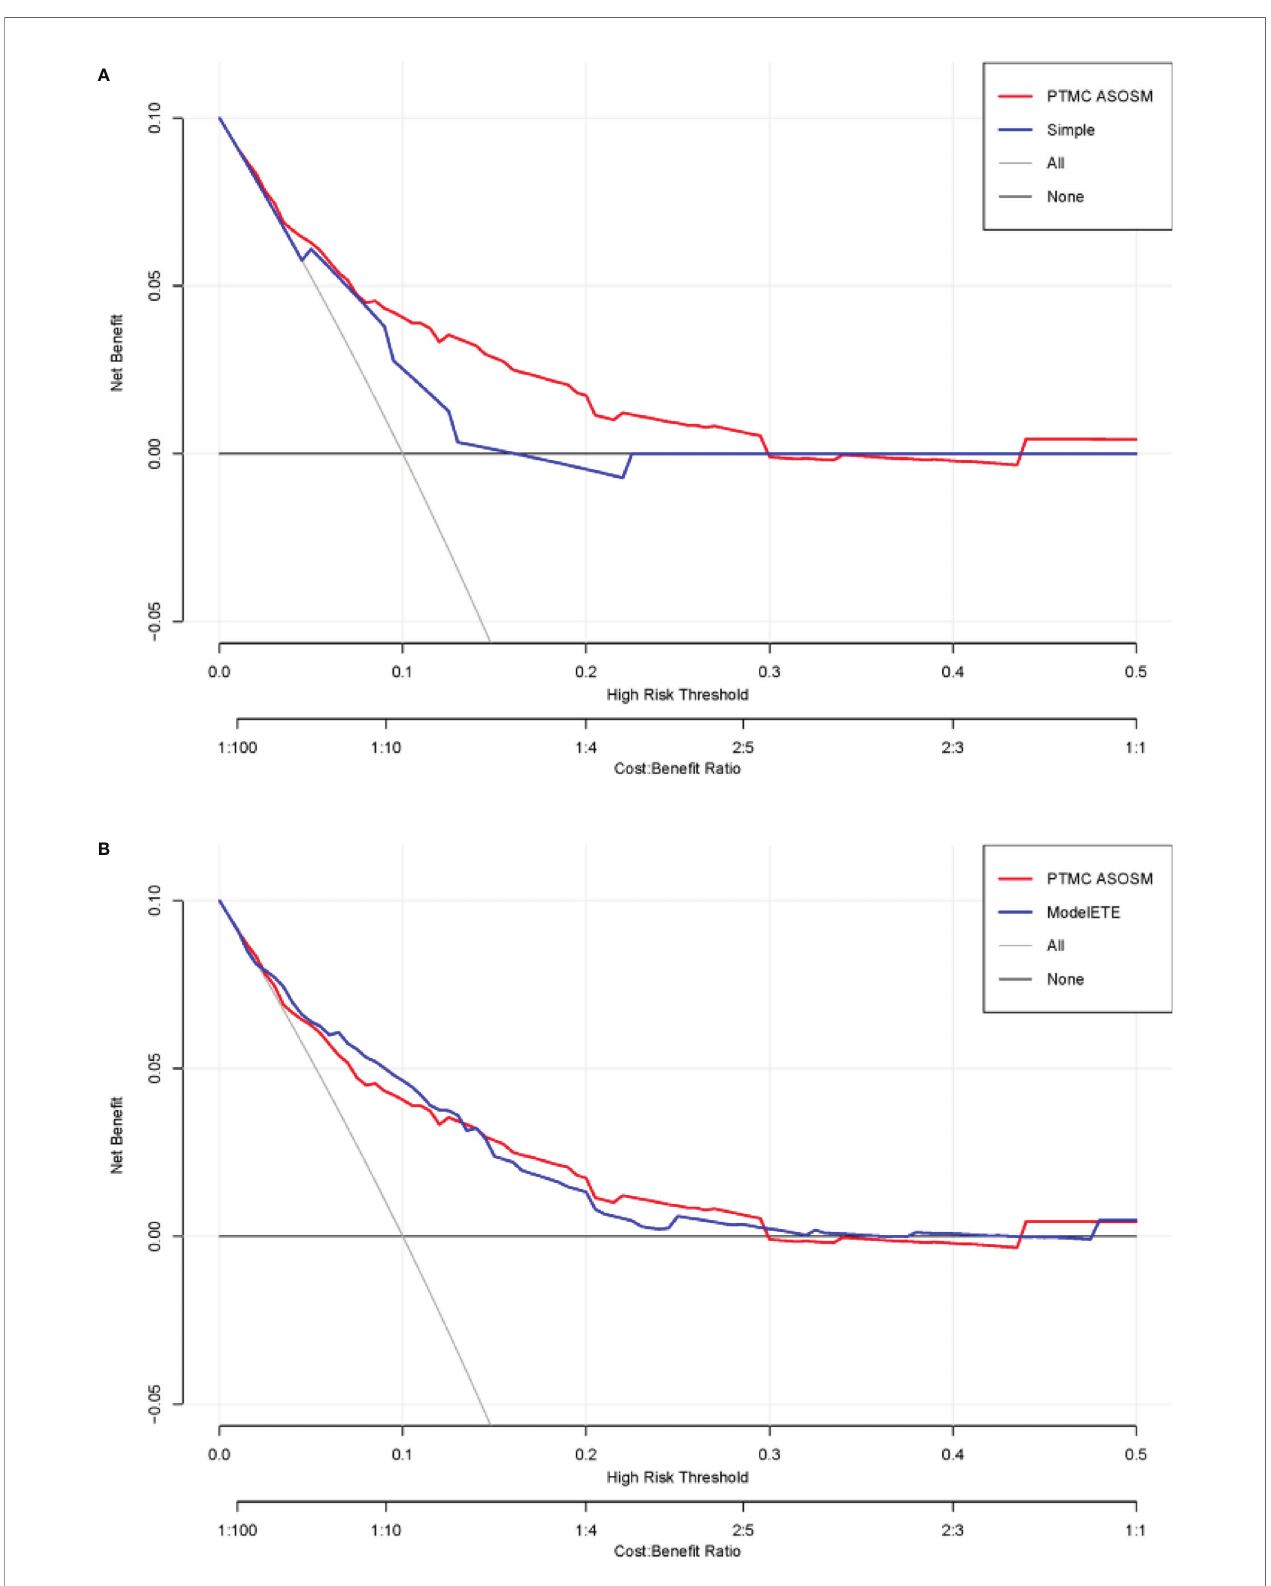
FIGURE 5 | DCA curves of the PTMC ASOS model and the previous model. (A) DCA curves of the PTMC ASOS model and simple model (age and gender). (B) DCA curves of the PTMC ASOS model and PTMC ASOS with